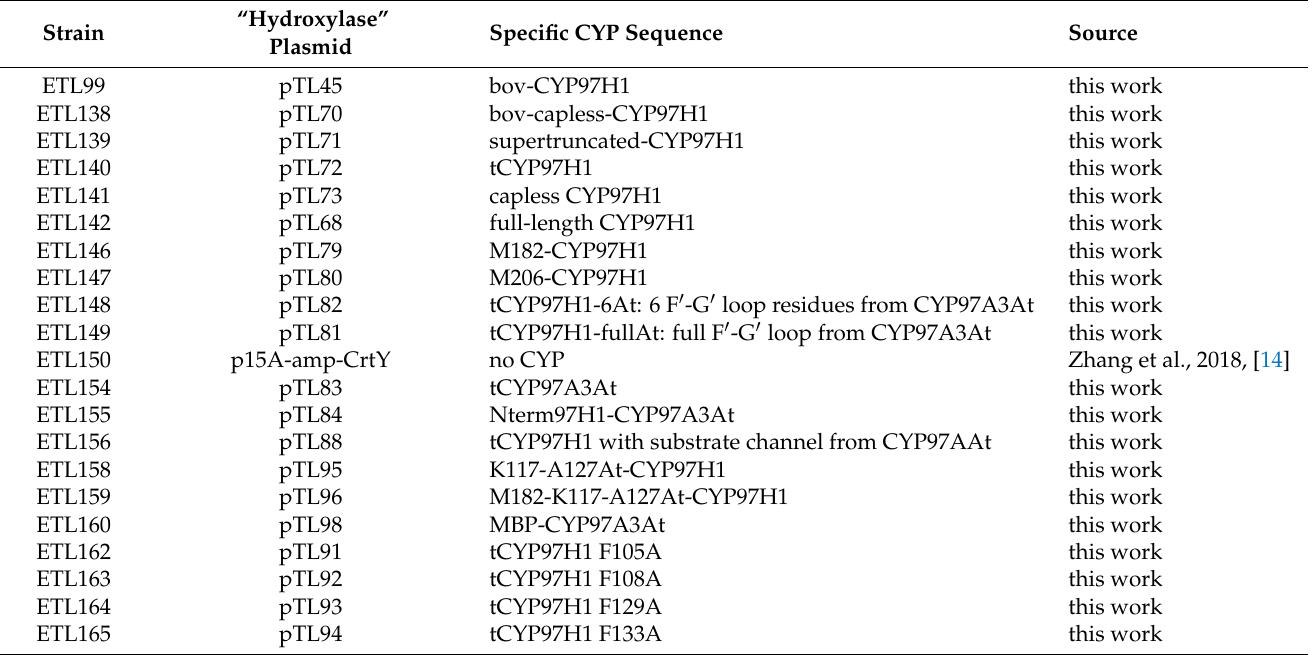
Table 1. Strains and plasmids used in this study. The core strain was a ETL90: BL21